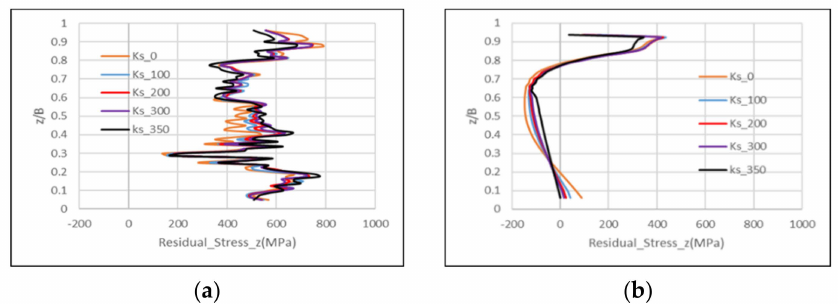
Figure 13. Welding residual stress in the welding direction at the thickness of 70 mm and a yield stress of 330 MPa: ( a ) welding center and ( b ) welding toe.